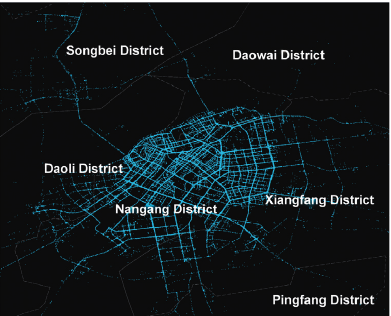
Figure 2: A one-day trajectory map of a sample of 3000 taxis within the study area.